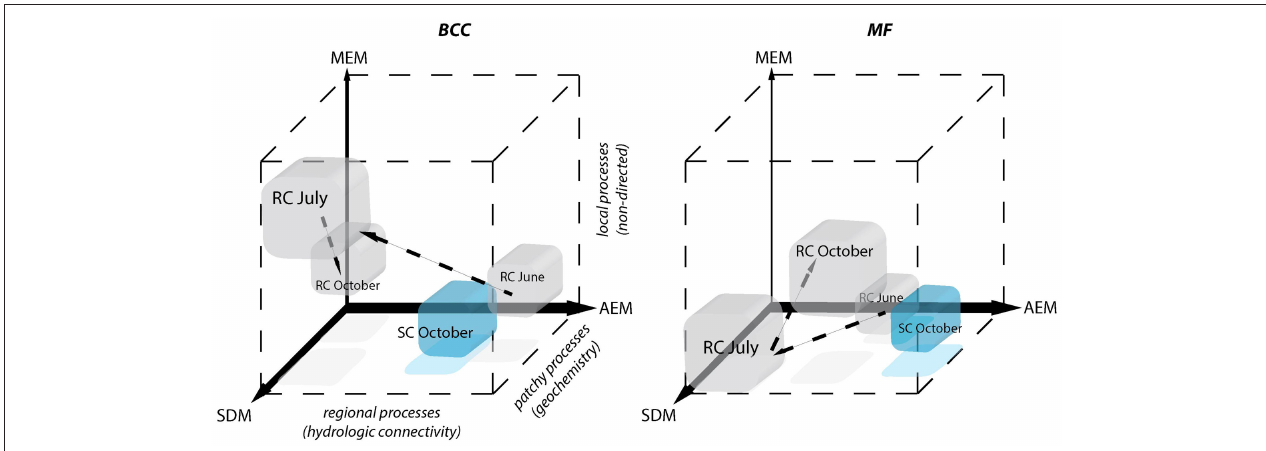
FIGURE 7 | Schematic depiction of the relative contributions of processes driving BCC and MF during different hydrologic periods. Positions of the cubes indicate the relative importance of each of the three models for the structuring of BCC and MF. AEM describes regional hydrologic drivers (downstream), MEM describes local connectivity related drivers that are not directed and SDM describes patchy solute characteristics. Patchy solute characteristics become more spatially structured (i.e., locally or regionally) when MEM or AEM model components gain importance simultaneously with SDM. The power of the different model components compared to one another is indicated by the width of the respective axes. Gray cubes correspond to the RC floodplain and successive changes during different hydrological periods are indicated by arrows. SC floodplain is depicted as a blue cube.